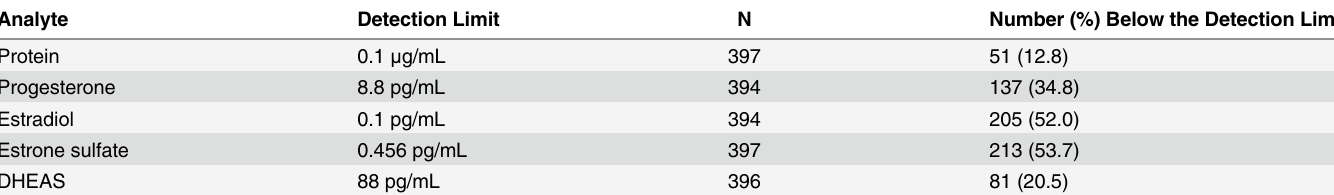
Table 3. Percentage of Ductal Samples Below the Detection Limit.